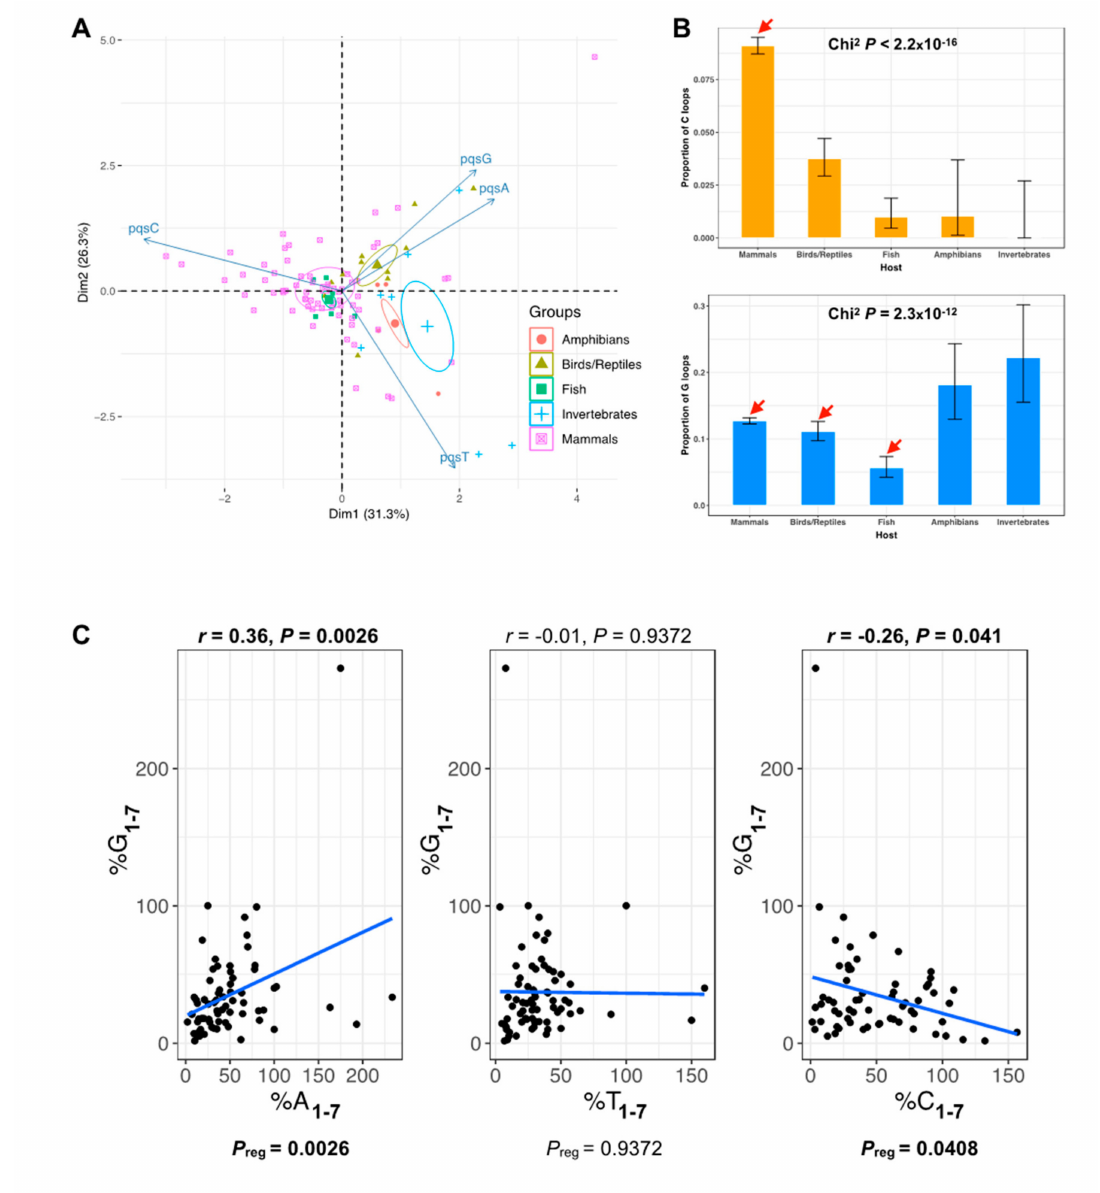
Figure 4. Herpesviridae viruses infecting mammalian hosts carry preferentially C-looped motifs. ( A ) Principal component analysis (PCA) performed on loop composition information (variables: PQS A , PQS T , PQS C , PQS G ) for 93 herpesviruses, without using host group information. Ellipses indicate barycenters (weighted center of mass) for each host group. ( B ) Proportion of single C (orange, top panel) or G (blue, bottom panel) loops by host group. Bars indicate the upper and lower bounds of the 95% confidence intervals. Chi-square independence tests were used to evaluate the significance of the association between loop proportions and host group. Red arrows indicate groups with pairwise nominal independence adjusted P -values < 0.05. ( C ) Relationship between PQS A (PQS T or PQS C ) motif and PQS G motif contents. Pearson correlation coe ffi cients are reported on each graph. Blue lines show linear regressions (P reg , linear regression